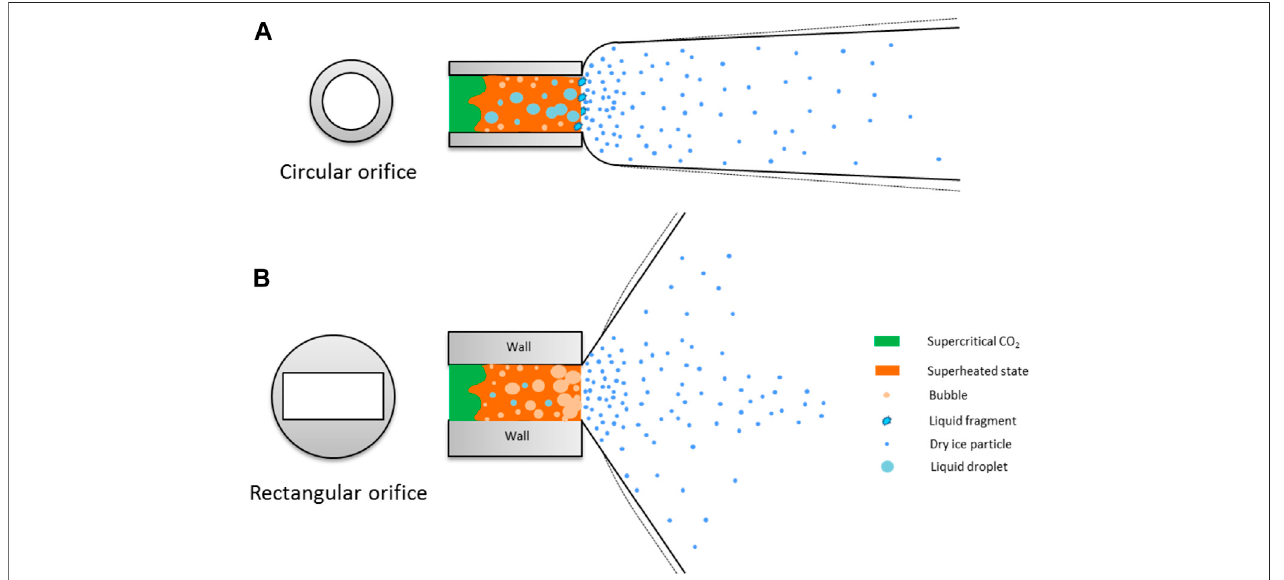
FIGURE 11 | Schematic of the supercritical CO 2 multiphase jet